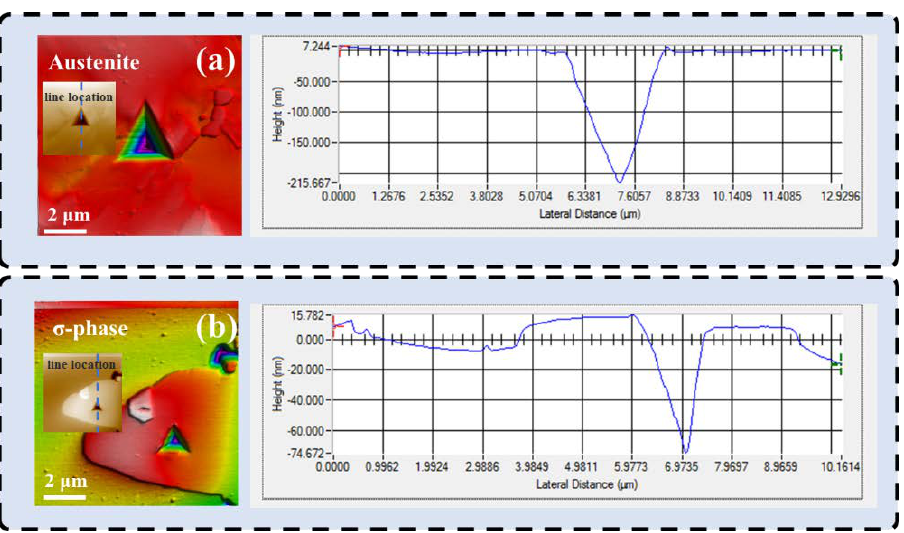
Figure 9. Three-dimensional shapes of indentations under 12 mN. ( a ) is the three-dimensional shapes of austenite and ( b ) is the three-dimensional shapes of σ -phase.